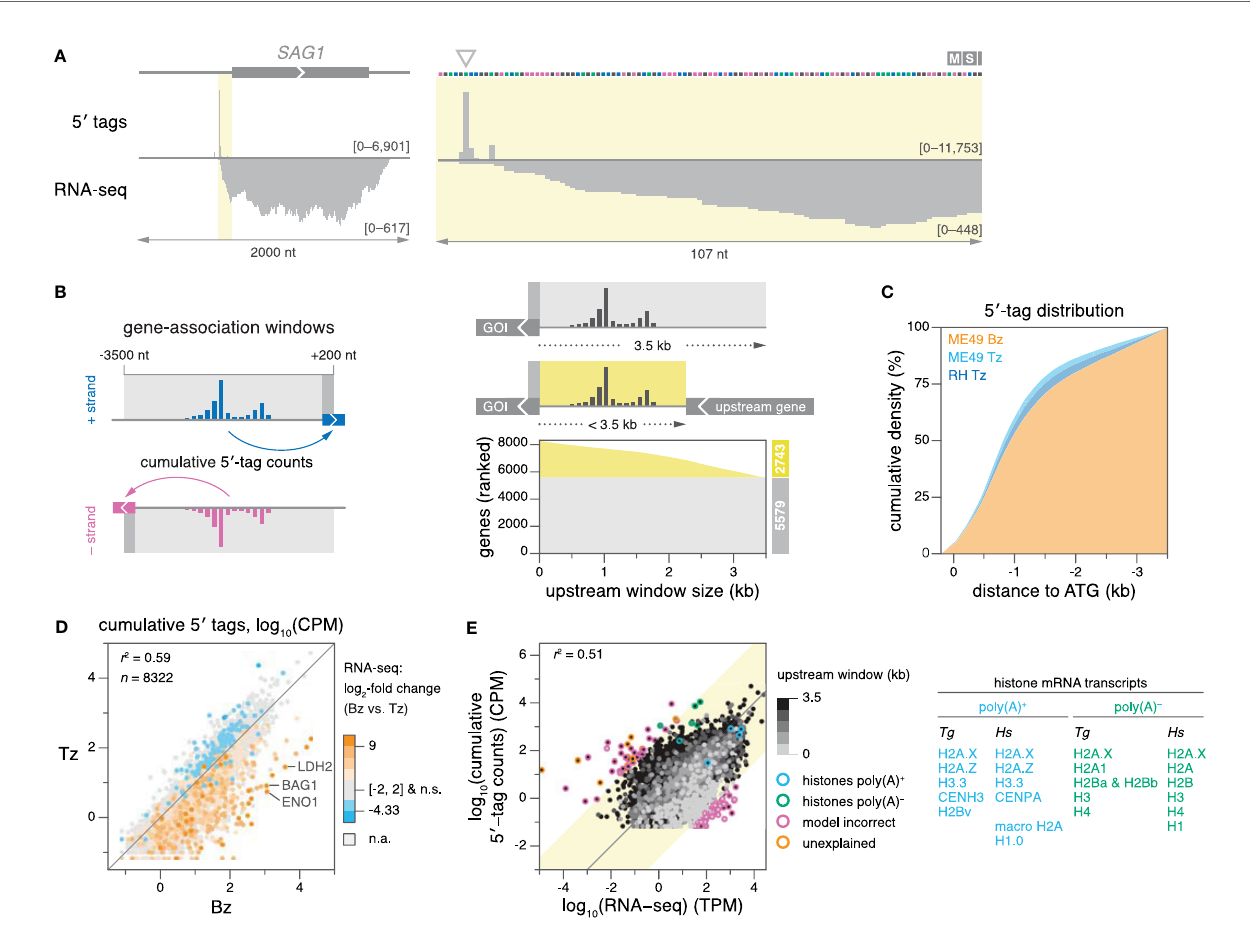
FIGURE 2 | 5 ′ -tag counts correlate with polyadenylation and gene expression measured by RNA-seq. (A) 5 ′ -tag and RNA-seq counts (ME49 Tz) on the (+) strand, upstream of the SAG1 ORF (left), and zoomed in (right). Arrow indicates the major TSS previously determined (Burg et al., 1988). Data ranges indicated in counts per million (CPM) for 5 ′ -tag data, and in transcripts per million (TPM) for RNA-seq data. (B) Strategy for associating 5 ′ tags to ME49 gene models. Strand-speci fi c gene- association windows were de fi ned around the start codons of 8322 protein-coding genes (left). The sum of all 5 ′ -tag counts within a window constitutes a gene ’ s cumulative 5 ′ -tag count. Where applicable, upstream windows were shortened by the stop codon of an upstream gene on the same strand, or by contig boundaries (right). The graph shows the upstream window size of genes in ranked order. (C) Empirical cumulative density plots of gene-level – normalized 5 ′ -tag counts from proximal to distal positions within windows. GOI, gene of interest. (D) Correlation of cumulative 5 ′ -tag counts between ME49 Bz and Tz. Genes are colored according to differential expression in Bz compared to Tz (log 2 scale). Several canonical Bz genes are indicated. n.s., not signi fi cant. n.a., not applicable, i.e., genes below the coverage threshold required to calculate statistical signi fi cance. (E) Comparison of ME49 Tz cumulative 5 ′ -tag counts (replicate-averaged) and Tz RNA-seq for relative quanti fi cation of gene expression (left). For clarity, genes with zero counts in either dataset are omitted. Genes are gray-shaded according to the size of their upstream gene-association window. RNA-seq libraries were generated using oligo(dT) priming for mRNA enrichment via poly(A) tails. Histone genes are highlighted according to the poly(A) status of their transcripts. Genes beyond three standard deviations (yellow background) are highlighted according to the accuracy of their model. Table of Toxoplasma ( Tg ) histone genes paired with their human ( Hs ) orthologues, grouped by the poly(A) state of their mRNA (right) (Da ́ vila Lo ́ pez and Samuelsson, 2008). The mRNA of H2A.X has both poly(A) and poly(A)-independent sequence we used annotations from the Toxoplasma genome database models, we de fi ned strand-speci fi c gene-association windows from -3500 to +200 nt relative to the start codons of all 8322 protein-coding genes in the reference annotation (version 45) ( Figure 2B , left). Windows extended 200 nt into annotated open reading frames (ORFs) to enable the capture of 5 ′ tags for genes with erroneously-annotated start codons. The upstream distance of 3500 nt was chosen to maximize the number of genes for which the full distribution of 5 ′ tags could be captured, while minimizing the risk of erroneously capturing pervasive transcription from neighboring genes. As a point of reference,